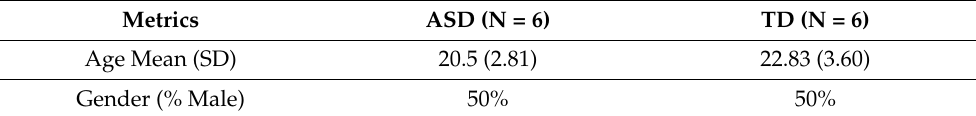
Table 2. Participant